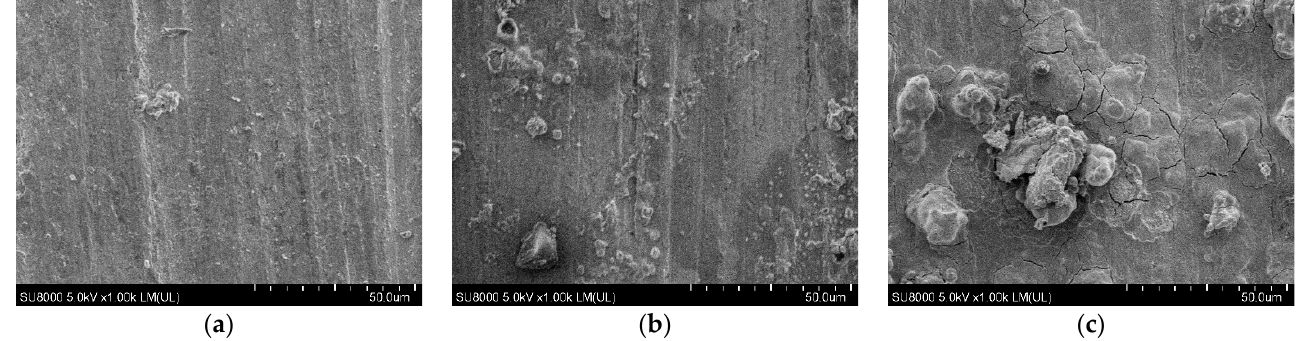
Figure 2. Microscopic corrosion morphology of hanging piece under different temperatures and pressure. ( a ) 298 K + 0.5 MPa; ( b ) 308 K +2.5 MPa; ( c ) 313K + 3.5 MPa.